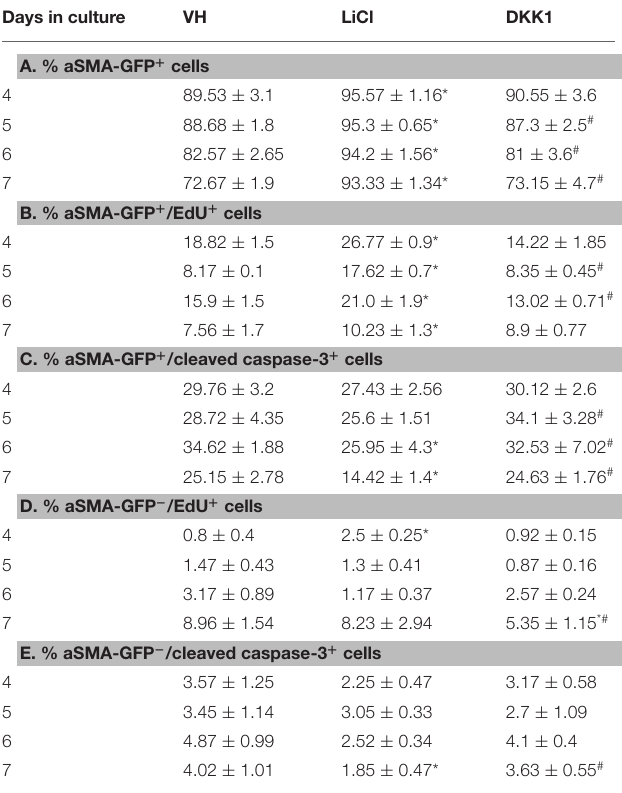
TABLE 1 | Effects of early exposure to LiCl on the percentage of α SMA-GFP + cells and their survival in primary dental pulp cultures.